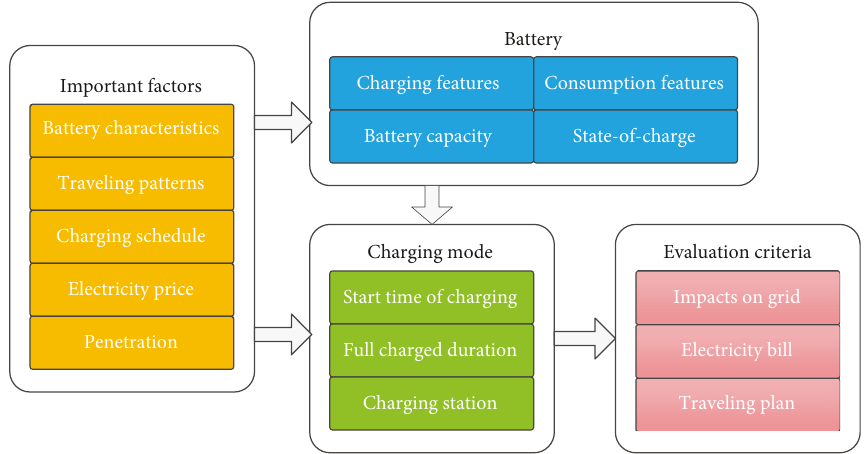
Figure 1: The impact factors of EV charging to the power